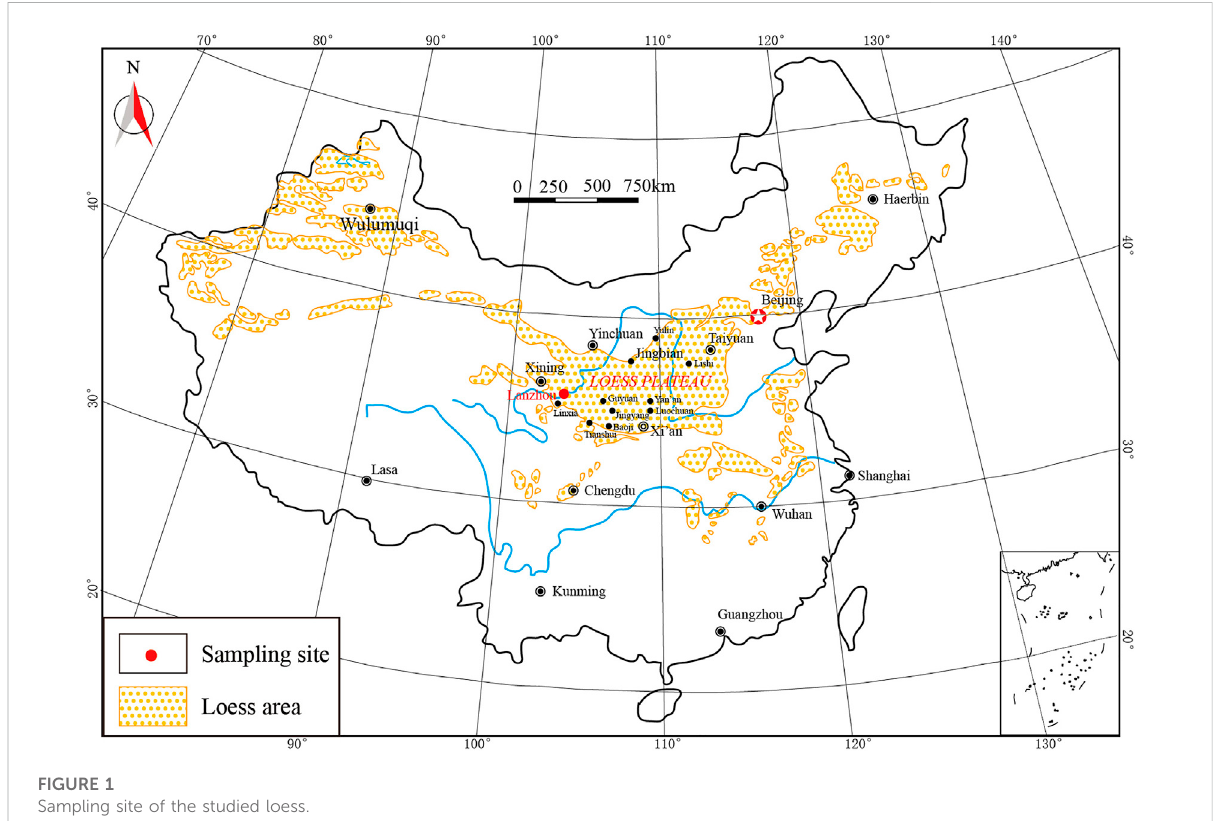
FIGURE 1 Sampling site of the studied loess.